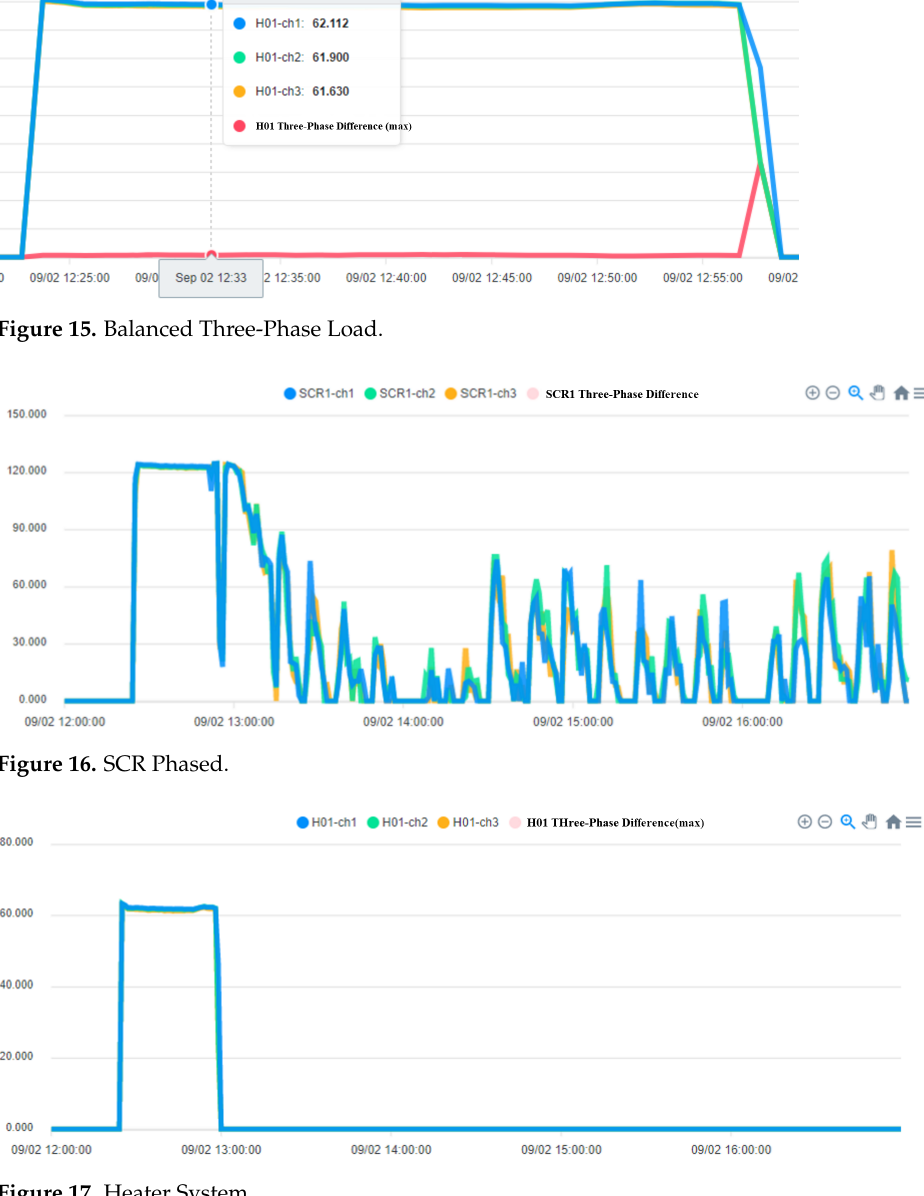
Figure 17. Heater